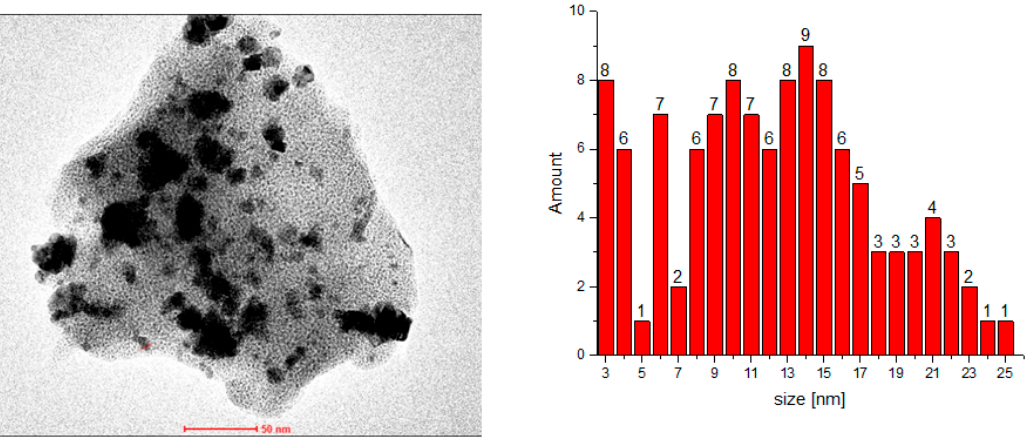
Figure 6. Morphology and size distribution of C1 Pd/DNA [33].